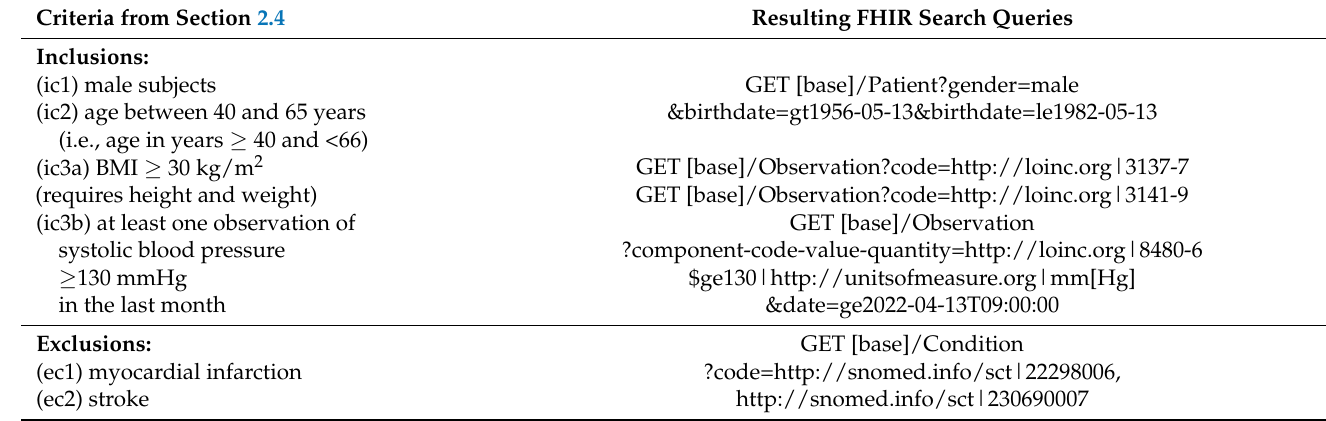
Table 1. Example FHIR Search queries for the inclusion and exclusion criteria listed in Section 2.4. The query execution timestamp is assumed to be 13 May 2022 09:00:00. Here, “[base]” is a placeholder for an FHIR server uniform resource location